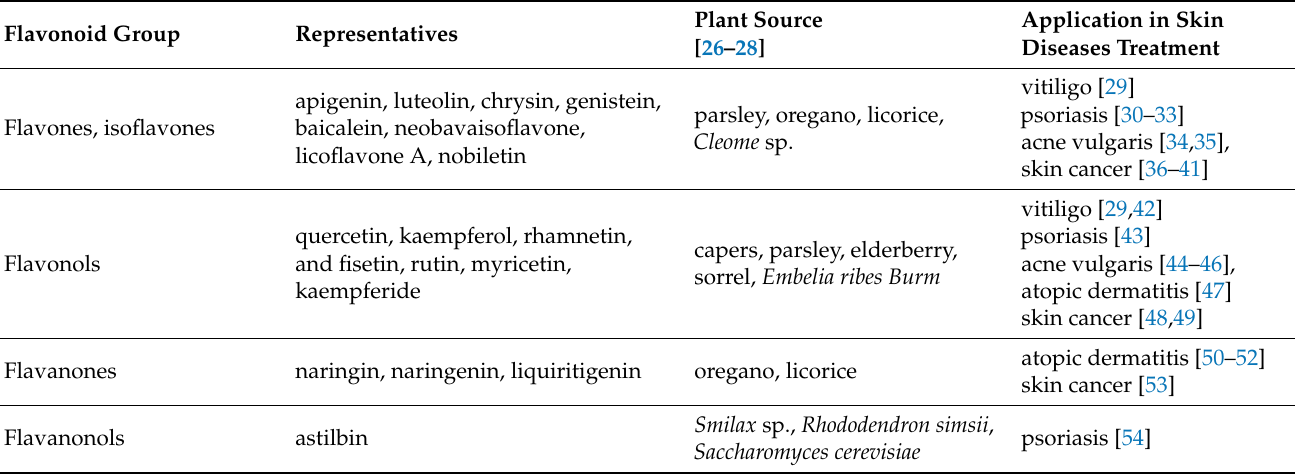
Table 1. Plant sources of